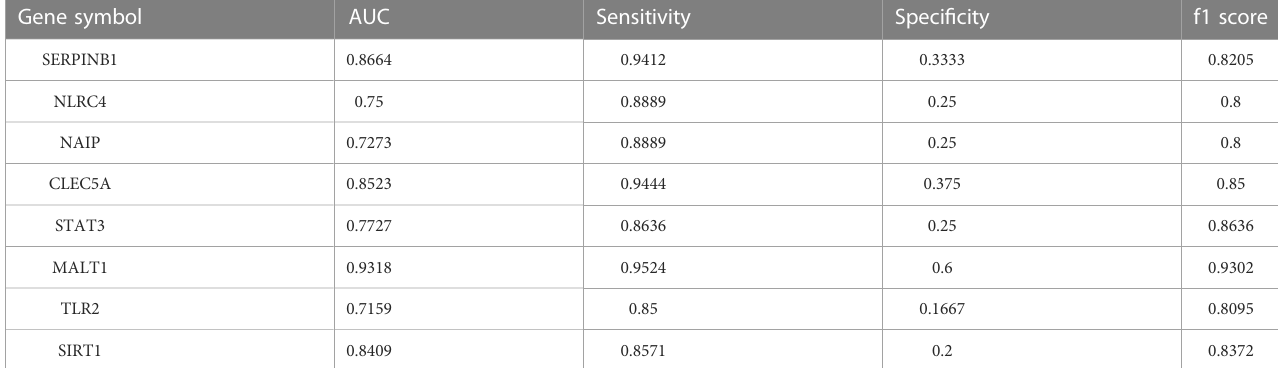
TABLE 2 AUC, sensitivity, speci fi city, and f1 score of the diagnostic model composed of a single gene on the internal test set. Gene symbol